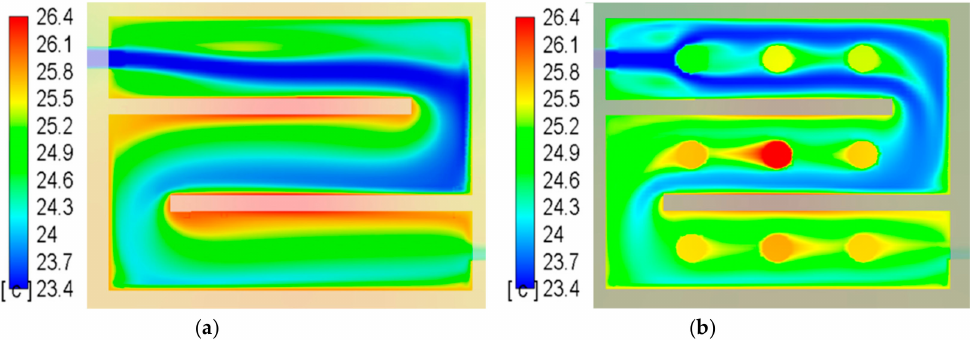
Figure 9. The calculated temperature ( ◦ C) distributions at the midplane of the cooling block: ( a ) Cooling block with plane cover; ( b ) Cooling block with finned cover ( H = 7 mm, and m = 0.0025 kg /